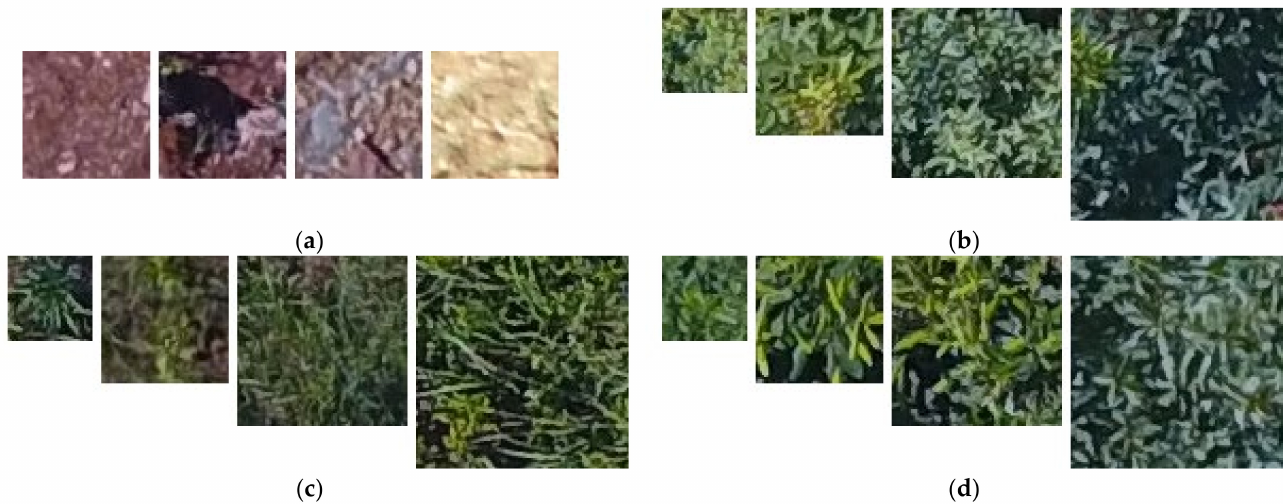
Figure 2. Examples of samples at different sizes. ( a ) Negative samples of soil with a resolution of 60 × 60 pixels. ( b ) Positive samples of trees with a resolution of 40 × 40~100 × 100 pixels. ( c ) Negative samples of weeds with a resolution of 40 × 40~100 × 100 pixels. ( d ) Negative samples of shrubs with a resolution of 40 × 40~100 × 100 pixels.